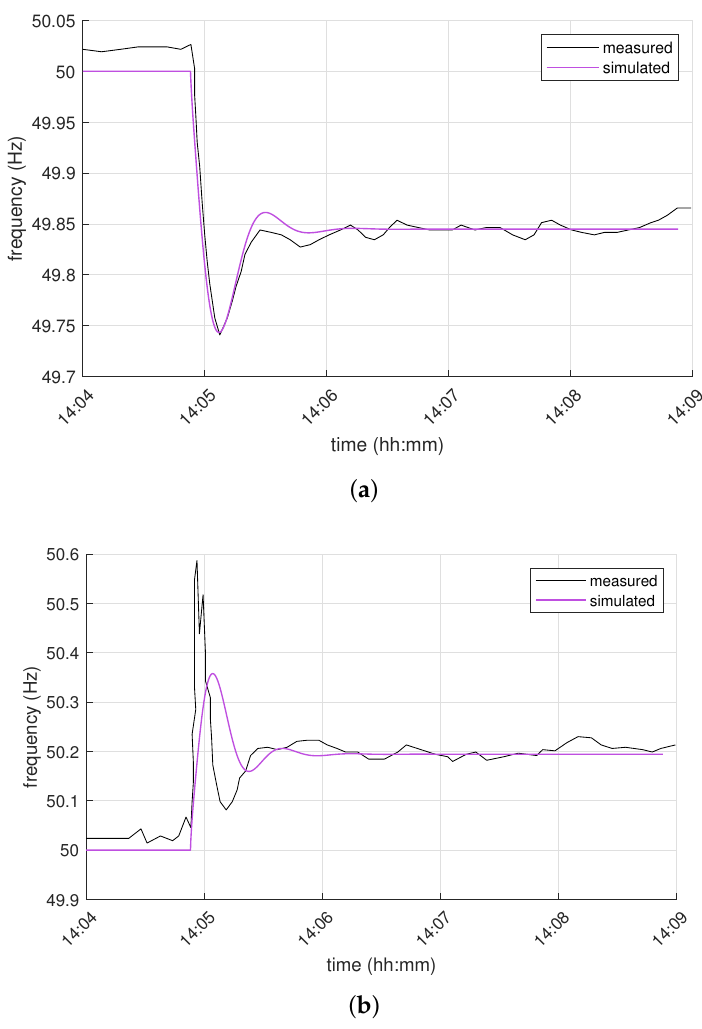
Figure 10. Comparison of simulation results with power imbalances and defensive actions concen- trated at the same time: ( a ) frequency in North-West part; ( b ) frequency in South-East part. From the results of Figure 11, it is possible to observe that the maximum instantaneous frequency deviations were approximately 250 mHz in the North-West part (minimum 49.75 Hz) and 550 mHz in the South-East part (maximum 50.55 Hz). The maximum rate of change of frequency (RoCoF) was − 0.0431 Hz/s for the North-West part and 0.3614 Hz/s for the South-East part. The RoCoF values are computed over an average time-window of 500 ms, as indicated by ENTSO-E [40]. Some minutes after the occurrence of the system split, the maximum quasi-steady-state frequency deviations were approximately 150 mHz in the North-West part (steady-state value 49.85 Hz) and 200 mHz in the South-East part (steady-state value 50.2